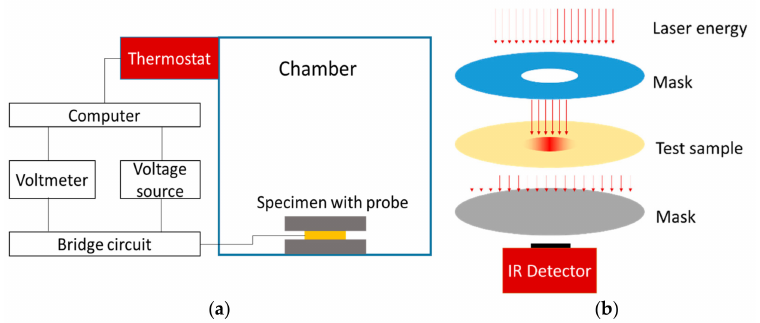
Figure 1. Schematics of the methods to measure thermal di ff usivity: ( a ) Transient plane heat source method; ( b ) Thermal di ff usivity by the flash